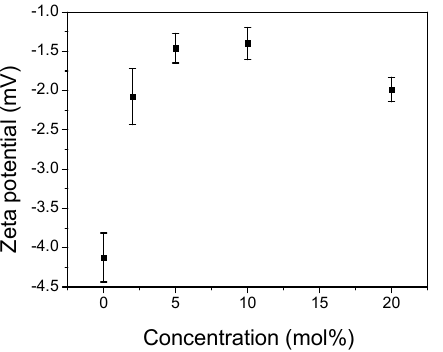
Figure 5. Zeta potential (ZP) of the 0.08 mg/mL DPPC membrane in the presence of increasing amounts of CT. Error bars are SDs calculated for three different repetitions.